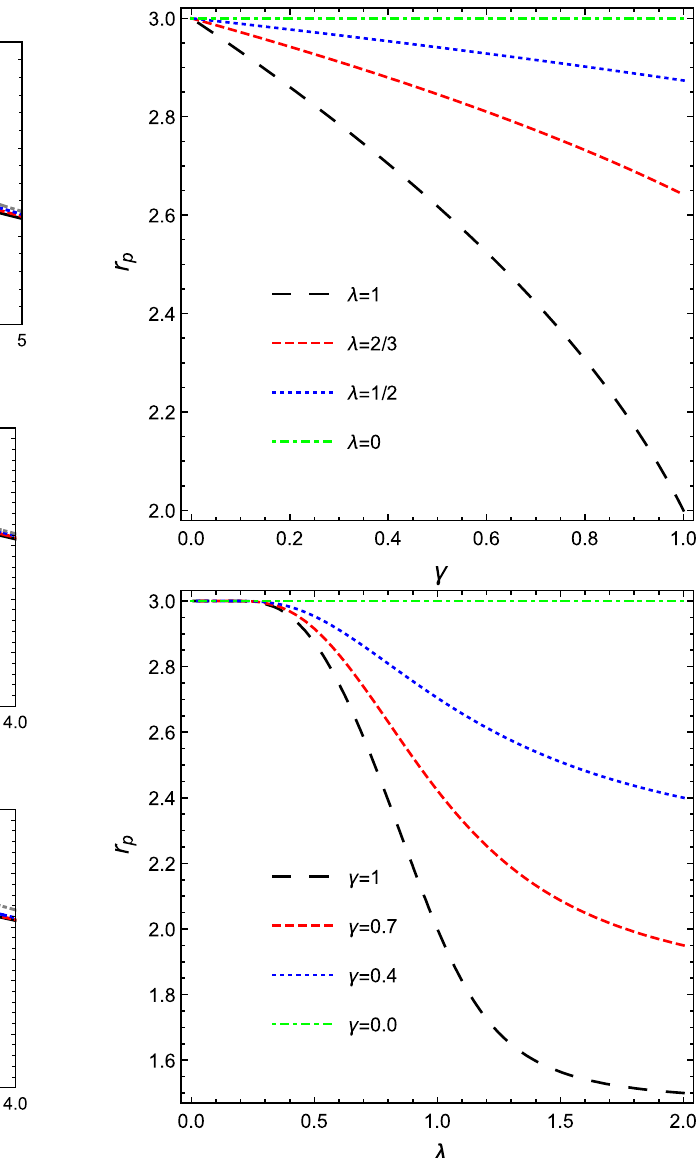
Fig. 7 Dependence of radius of photon r ph on parameters γ and λ in the KR spacetime